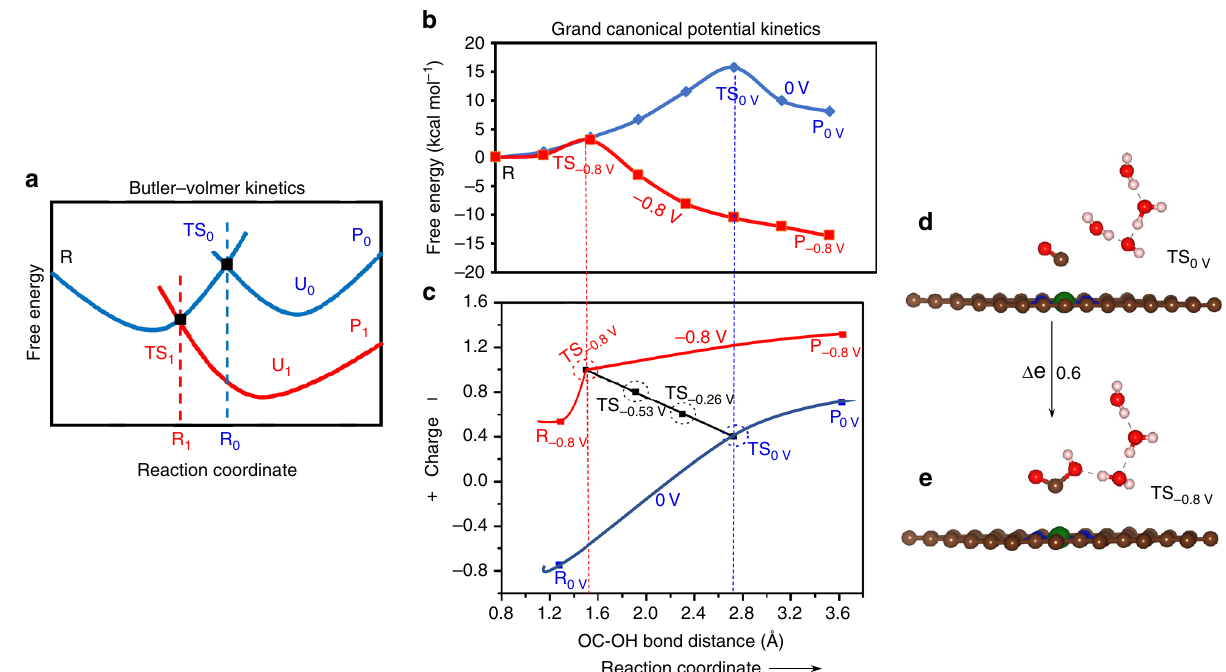
Fig. 5 Schematic and quantitative description of the reaction kinetics. a The traditional Butler – Volmer reaction kinetics. Starting from product (blue curves), at zero applied potential, ( U 0 ) the reaction between reactant, R and product, P 0 shows a transition state (TS 0 ) with R 0 spatial distance along the reaction path. The transition state (TS 1 ) shifts toward the reactant with lower in free energy gives R 1 spatial distance at applied potential U 1 between reactant R and product P 1 (red curves). The product forms with a single electron transfer from electrode to product, leading an electron transfer jump along the reaction pathway. b , c Grand canonical potential kinetics methodology, illustrating the relationship between the TS geometry and charge as the reaction changes continuously with applied potential, leading to a continuous potential dependent reaction path. The blue curve represents the reaction pathways for cis-COOH to CO conversion on Ni – N 4 site at zero (0 V) potential while the red curve is for − 0.8 V applied potential. At 0 V, the reaction between reactant, R or R 0V and product, P 0V produces a transition state (TS 0 ) with OC – OH = 2.77 Å (blue dotted line) and an energy barrier of 16.89 kcal mol − 1 . At − 1 with OC – OH = 1.46 Å (red dotted line). The black − 0.8 V applied potential the energy barrier for the transition state TS − 0.8V decreases to 2.98 kcal mol line connecting the transition states at 0 V (TS 0 ) and − 0.8 V (TS − 0.8V ) shows the linear continuous relation between the applied potential and species charge within the system. The dotted circles indicate the transition states at different applied potentials. d , e The geometry of the transition state at zero (TS 0 ) and − 0.8 V (TS − 0.8V ) applied potential, resulting a charge difference of 0.6 e . The arrow represents the TS direction on applied potential. (brown: carbon, blue: nitrogen, green: nickel, red: oxygen, off white: hydrogen